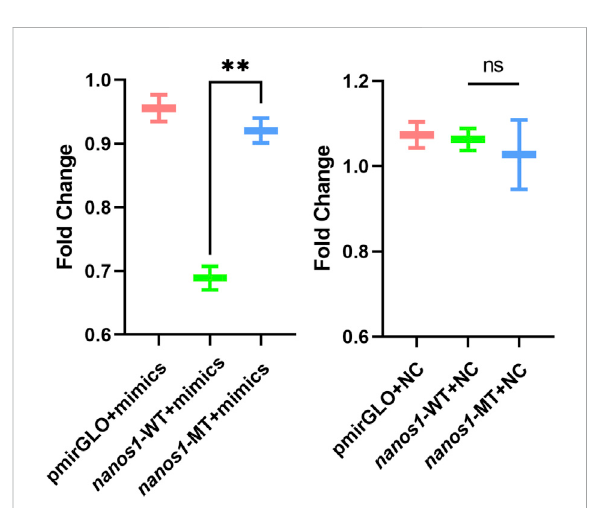
FIGURE 7 Veri fi cation of the regulatory effect of miR-9-5p on nanos1 in vitro . Dual-luciferase report assay detected the binding of miR-9-5p to nanos1 . **, 0.001 < p < 0.01, ns, no signi fi